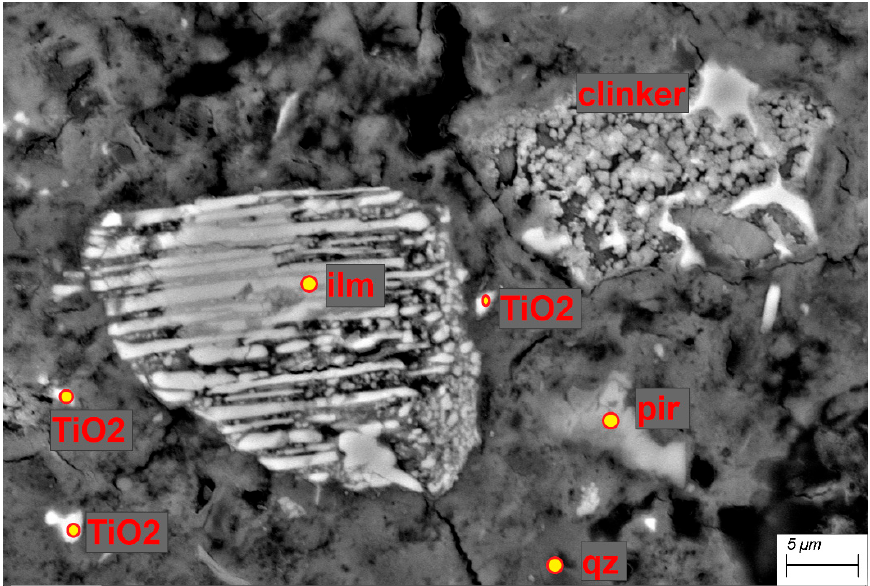
Figure 4. BSE image of cement mortar containing R-MUD; pir—orthopyroxene, ilm—ilmenite, qz—quartz and TiO 2 —titanium dioxide.